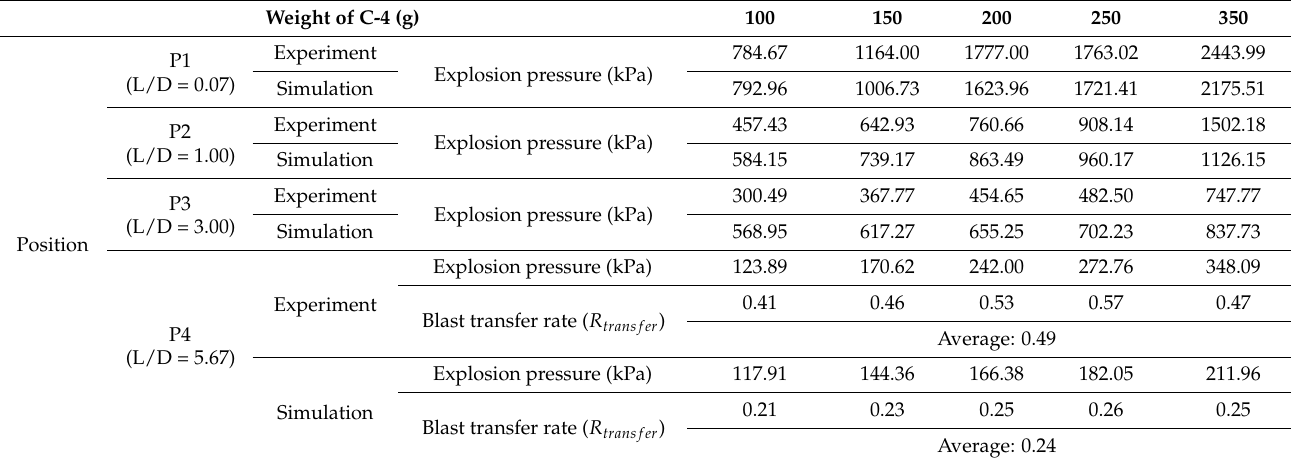
Table 2. Comparison of experiment and numerical results of steel tunnel with single-pressure relief orifice plate. Weight of C-4 (g) 100 150 200 250 350 P1 (L/D = 0.07)